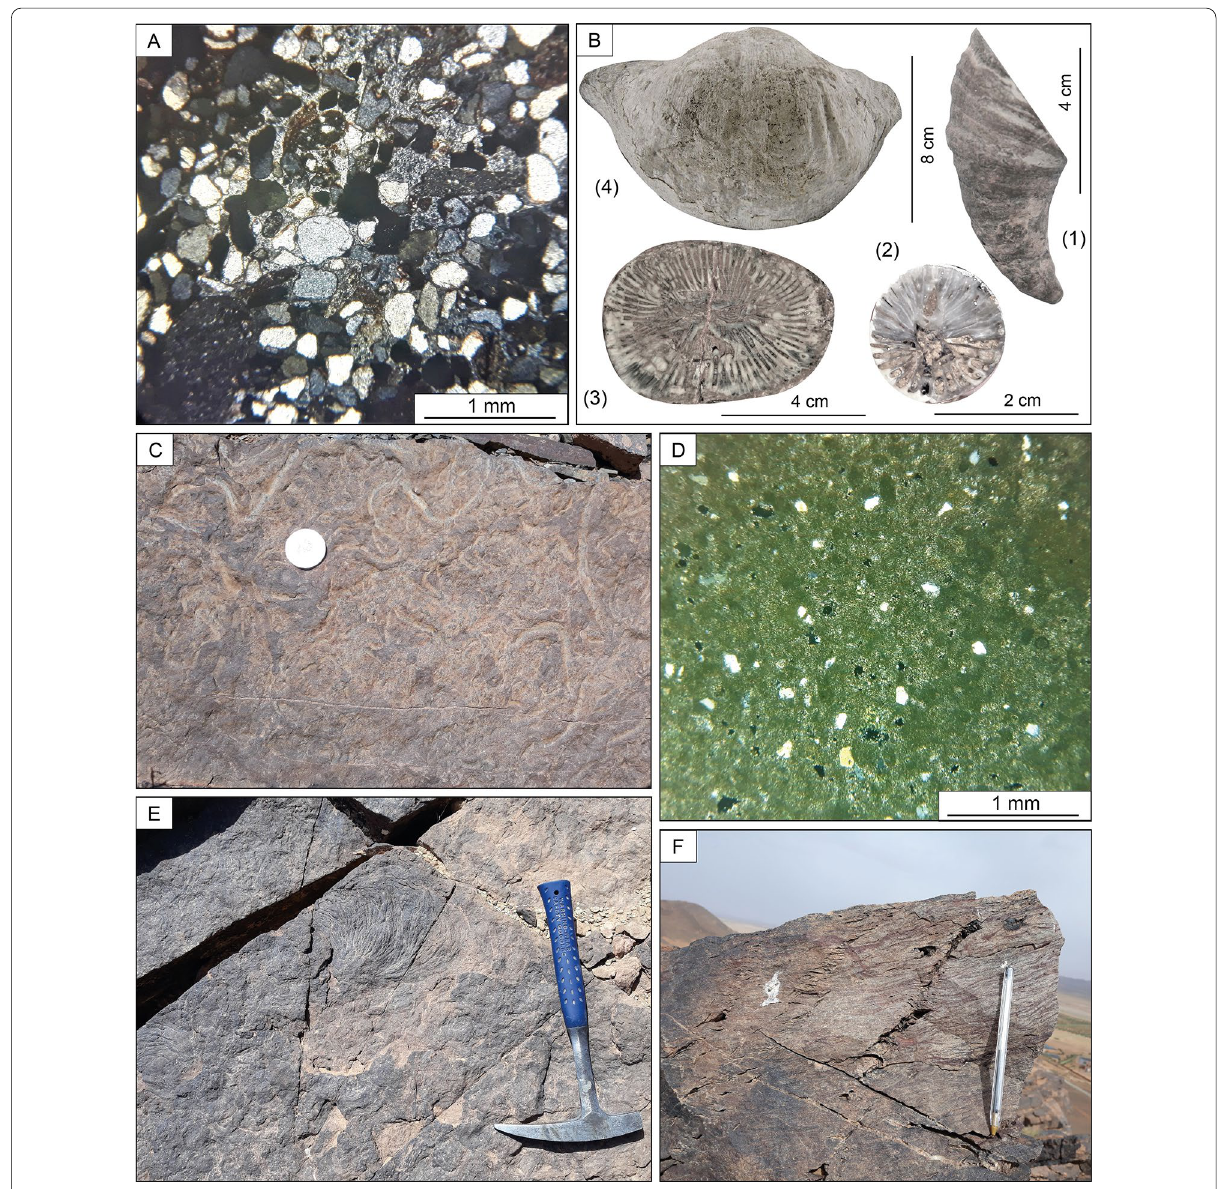
Fig. 4 Field photos of the studied outcrop, the microfacies and the macrofossil content (Jbel Asdaf area). A Microfacies of upper Tournaisian sandstones in the Aït Yalla Formation, showing fine facies with well-rounded elements, dominated by quartz. B Some macrofaunal fossils from the lower and upper intervals. 1–2. Zaphrentoides sp., 3. Caninophyllum skourense , 4. Gigantoproductus giganteus . C Bioturbation and traces fossils (burrows) in the lower interval. D Microfacies of lower Visean (middle interval) with organic material. E Trace fossils of the ichnogenus Zoophycos (middle/upper interval). F Laminated structures and algal mats (upper